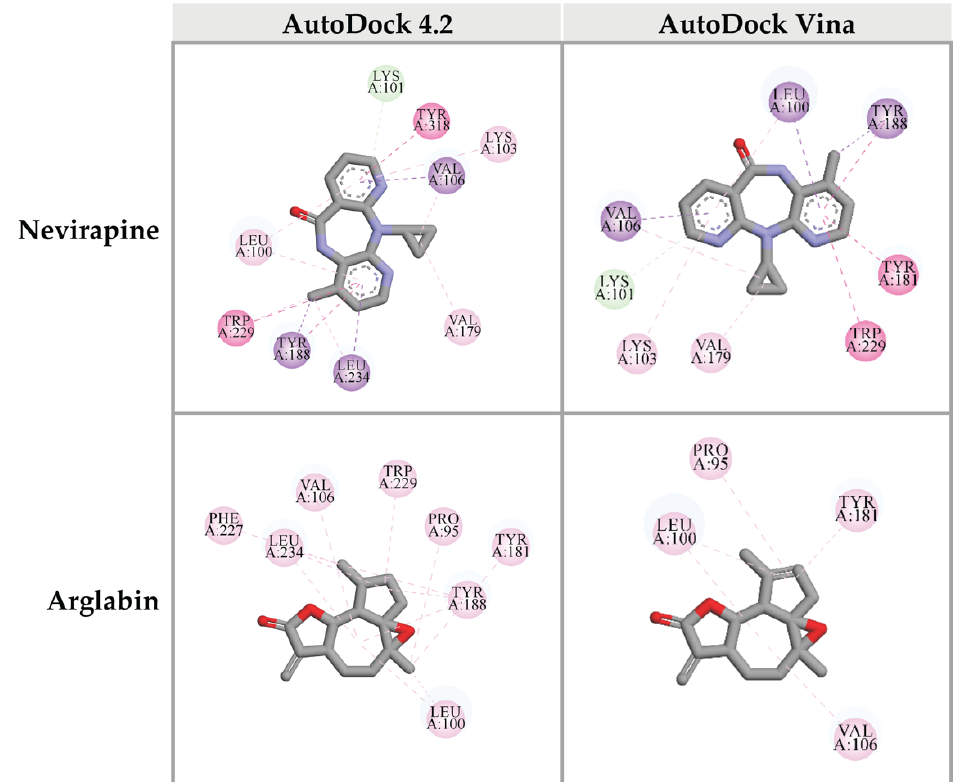
Figure 6. Three-dimensional schematic interaction between HIV-1 RT (PDB: 3QIP) at the DNA polymerase active site and candidate ligands. Balls and sticks represent amino acid residues and ligands, respectively. Green dashed lines indicate hydrogen bonds. Pink and purple dashed lines indicate hydrophobic bonds.